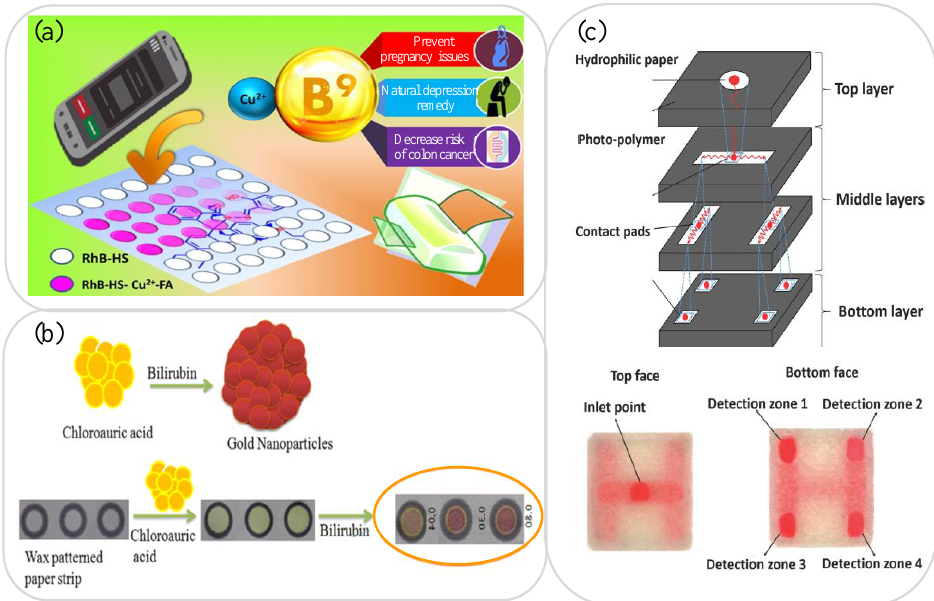
Figure 6. ( a ) Lab-on-paper platform with colorimetric probe for FA detection based on open-ring form amplification of RhB derivative. Reprinted with permission from ref. [154]. Copyright 2020 Elsevier. ( b ) Lab-on-paper device with in-situ formation of AuNPs for colorimetric determination of bilirubin. Reprinted with permission from ref. [156]. Copyright 2020 Springer. ( c ) A stacked four-layer cellulose paper lab-on-paper device for detection of BSA, glucose, nitrite and pH value in urine sample. Reprinted with permission from ref. [101]. Copyright 2020 Elsevier. Table 3. Summarizes the μPADs used for urine analysis. Edachana et al. [156] demonstrated a lab-on-paper device based on colorimetric method with AuNPs for the detection of bilirubin in urine samples. When chloroauric acid AuNPs in the presence of bilirubin, and the color change was used to analyze the